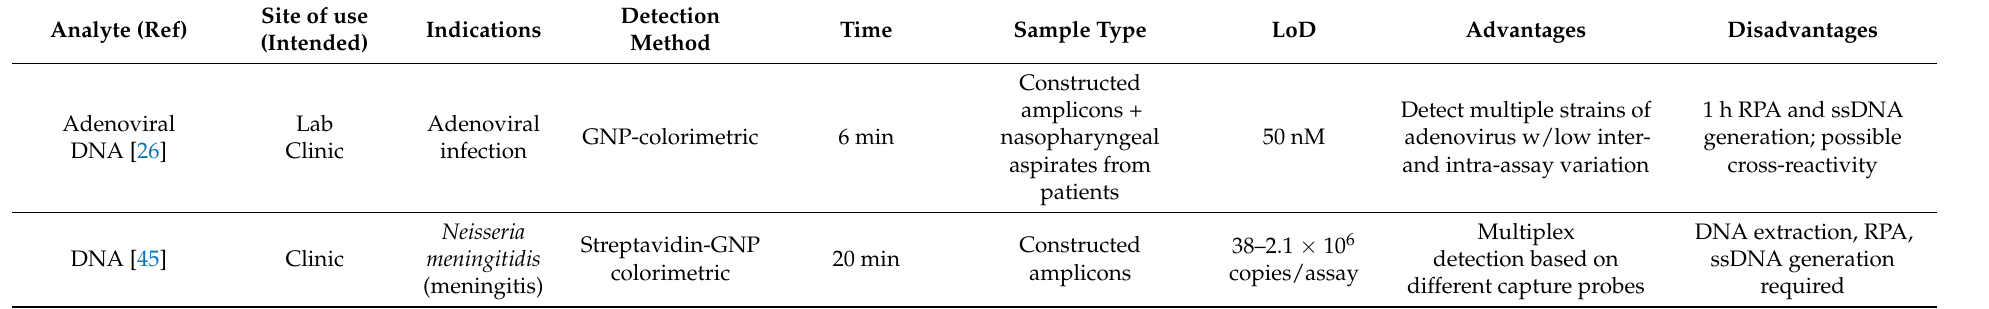
Table 4. Vertical flow assays for nucleic acid detection.